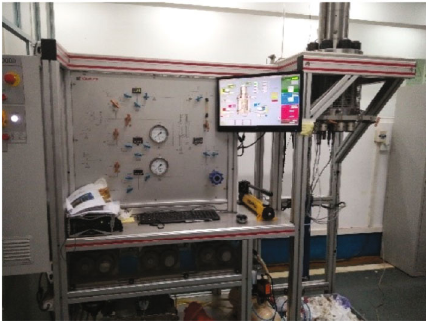
Figure 2: Triaxial multiphysics coupling testing system.